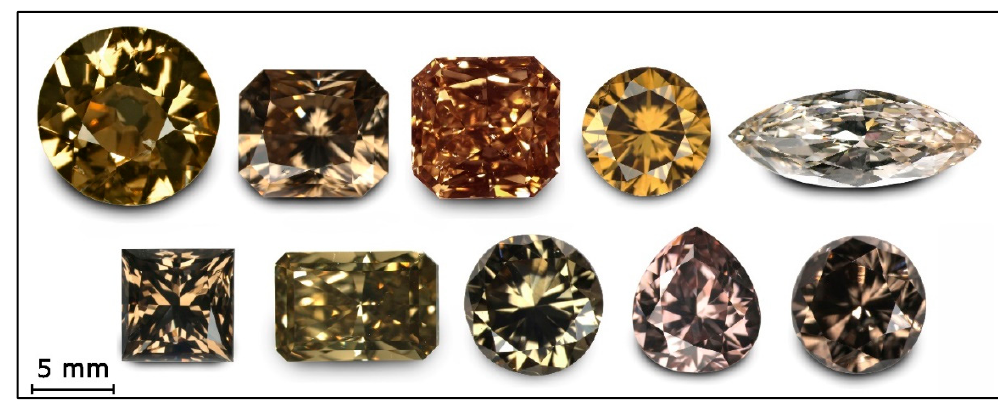
Figure 1. A variety of differently colored and shaped deformation-related brown diamonds.